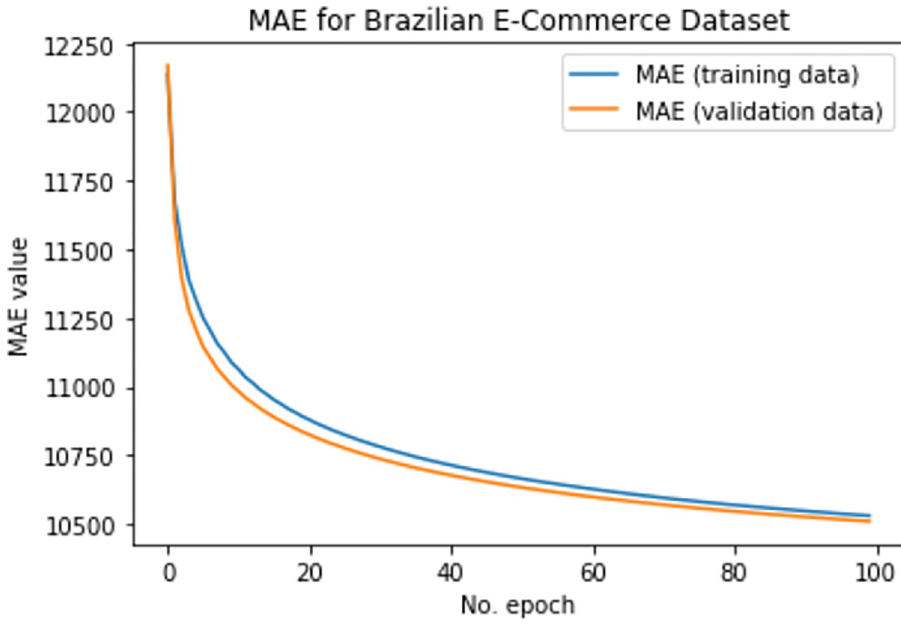
Fig 11. MAE for BE-dataset @100